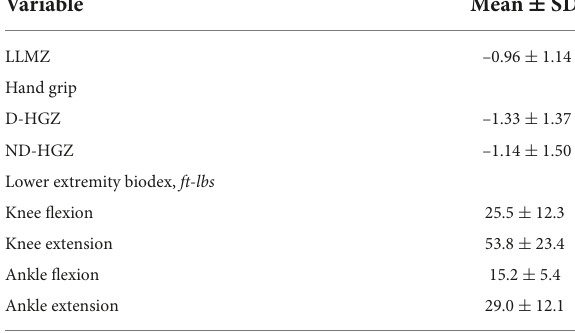
TABLE 1 Demographic and clinical characteristics of participants ( N = 25).